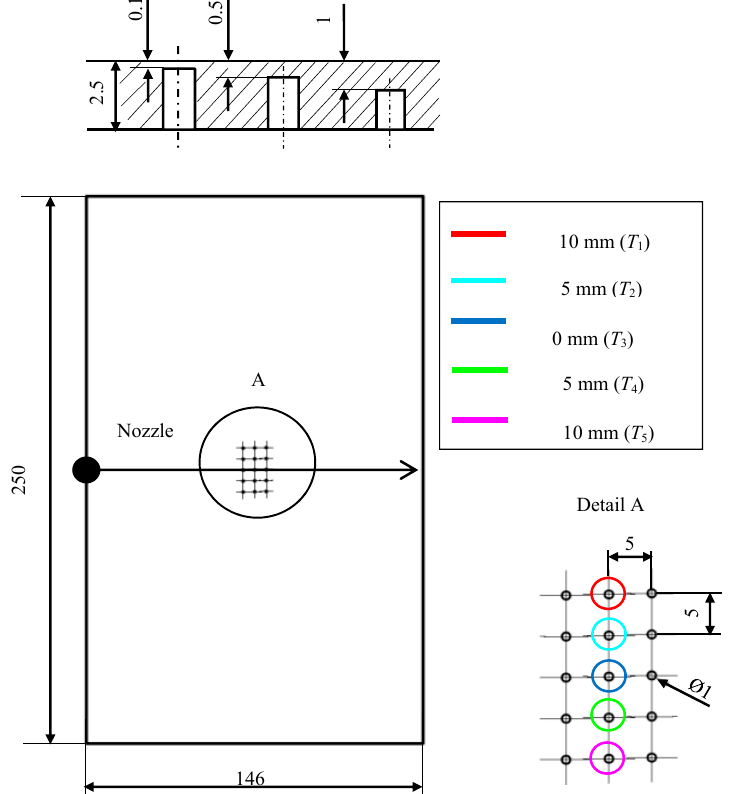
Figure 1. Schematic illustration of the moving nozzle with corresponding positions of the thermocouples and a cross section view of the holes at different depths [10].